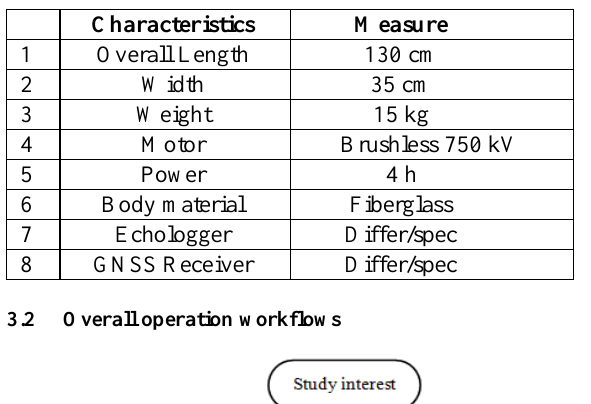
Table 1. Characteristics of the ROV boat prototype.